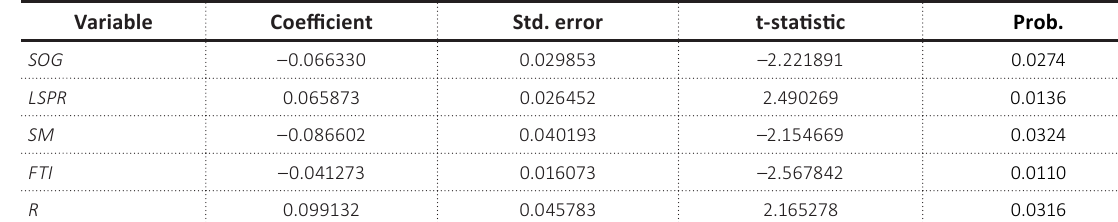
Table 4. The impact of each independent economic freedom variable on IRS